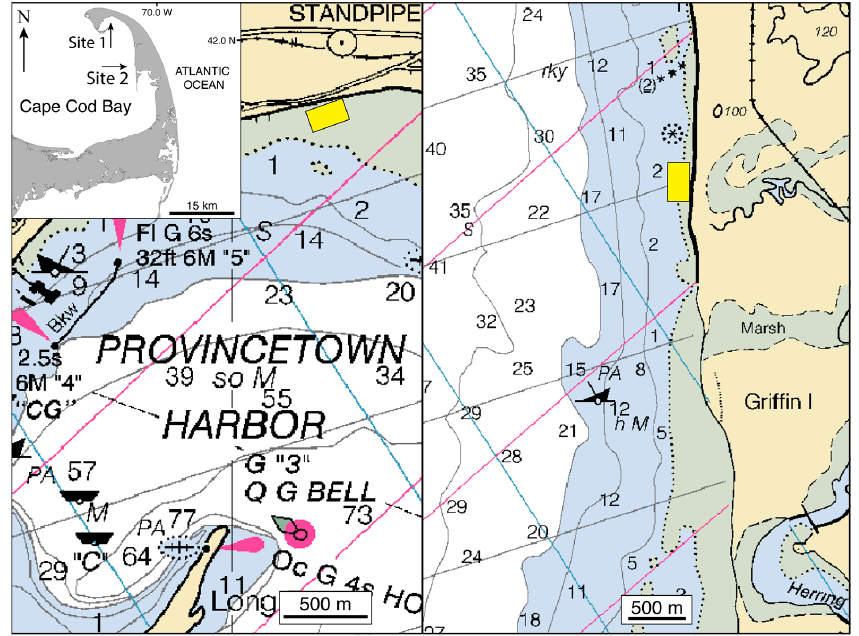
Figure 1. ( Left ) Site 1: sandy intertidal area in Provincetown Harbor. Inset locus map. ( Right ) Site 2: mixed sand and gravel beaches with predominantly cobble bottom. Yellow boxes are approximate locations of